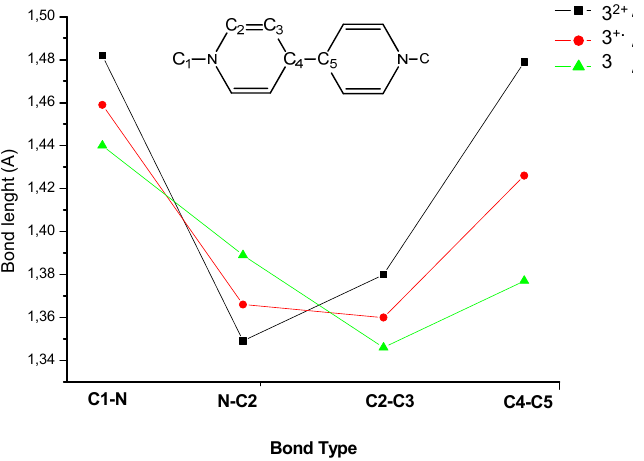
Figure 1. B3LYP/6–31+G* bond length variations during the oxidation process of 3